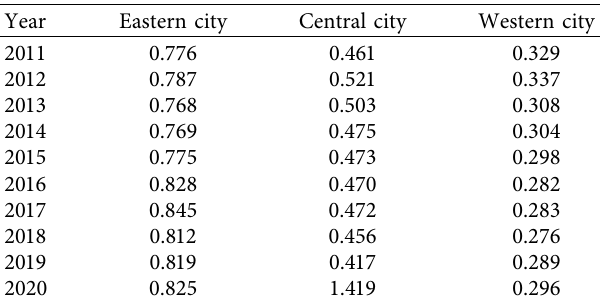
Table 3: Regional distribution of mean environmental efficiencies of node cities in the Chinese section of the SREZ in